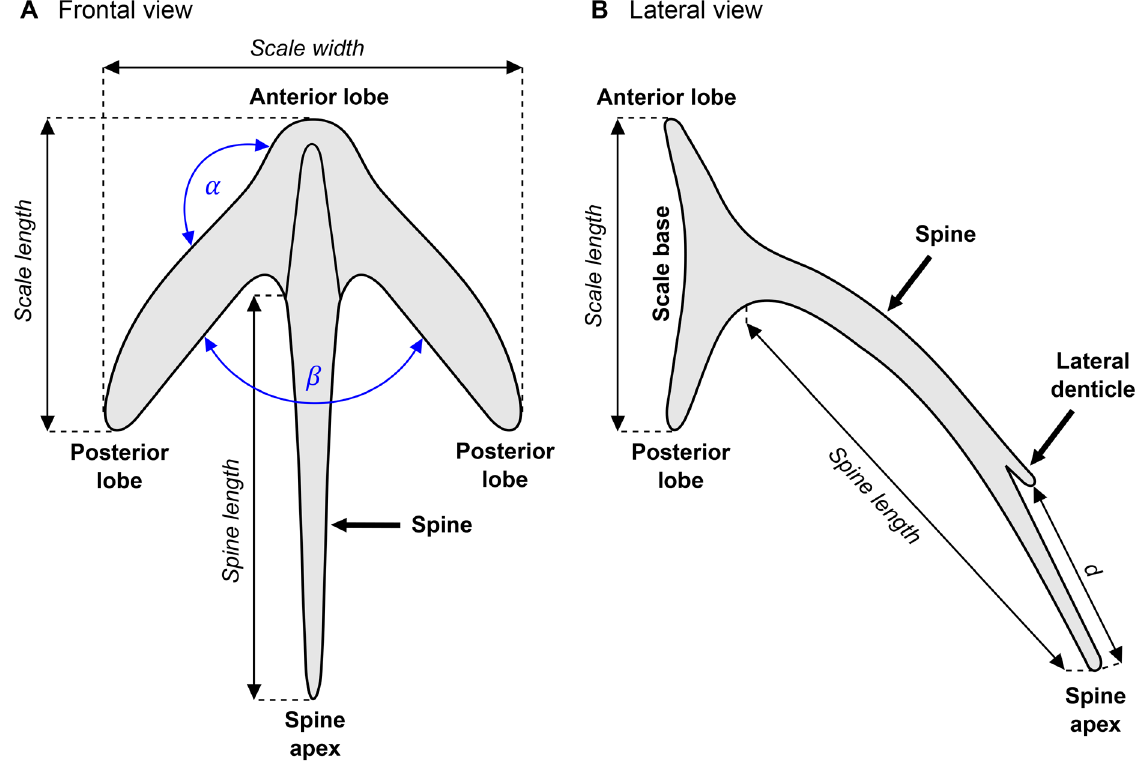
Fig. 3. Terminology and measurement scheme for scales and spines. A . Frontal view. B . Lateral